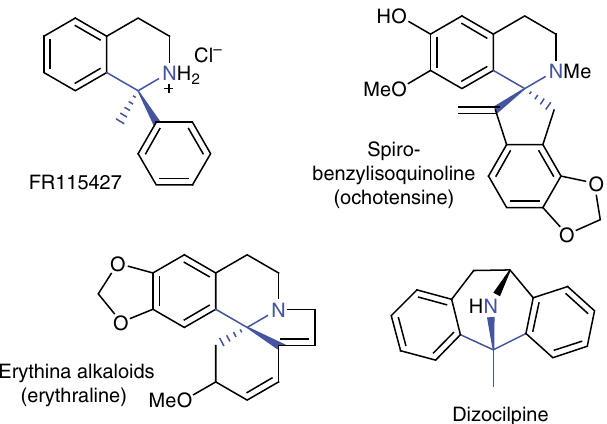
Figure 1 | Pictet–Spengler formation of 1,1 0 -disubstituted tetrahydroisoquinolines. Examples of 1,1 0 -disubstituted tetrahydroisoquinolines (THIQs), with the a -tertiary amine moieties highlighted in blue. FR115427 and dizocilpine are synthetic anticonvulsants. The Erythrina and spiro-benzylisoquinoline alkaloids are subgroups of plant benzylisoquinoline